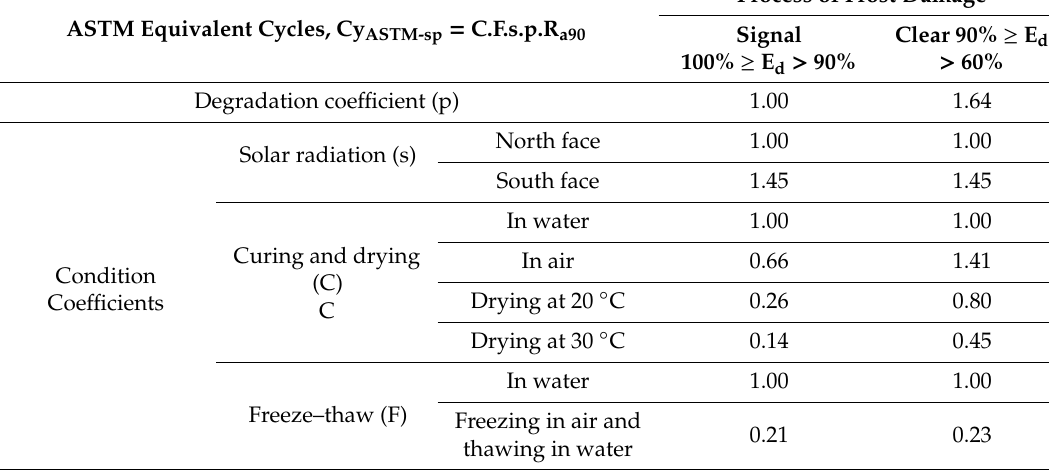
Table 2. Coe ffi cients for the Cy ASTM-sp